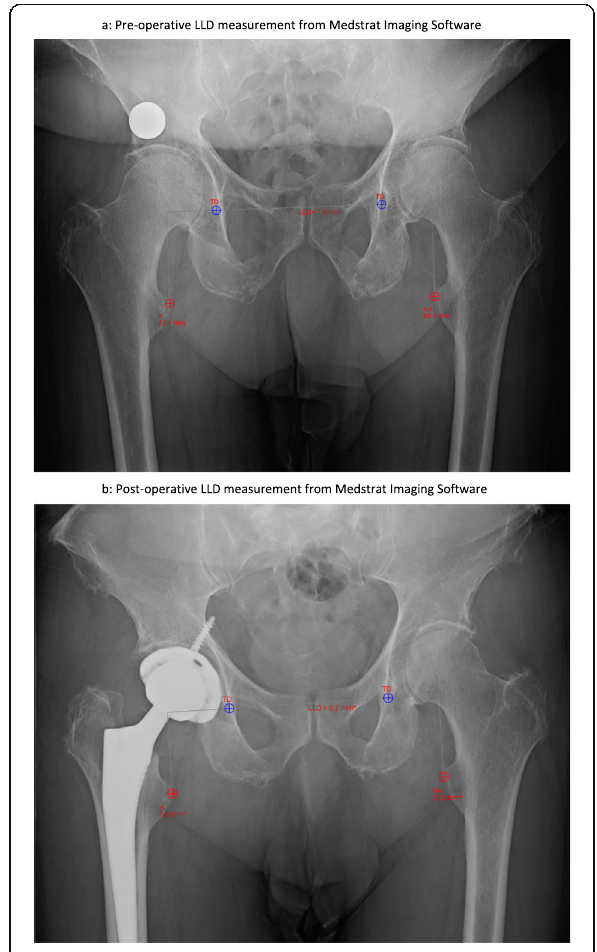
Fig. 1 a , b Preoperative and postoperative AP pelvis XR with LLD